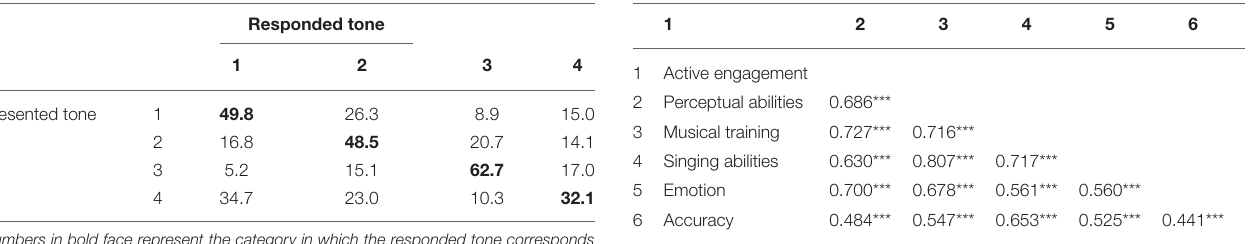
TABLE 3 | Table of Correlations for Gold-MSI variables and accuracy of tone